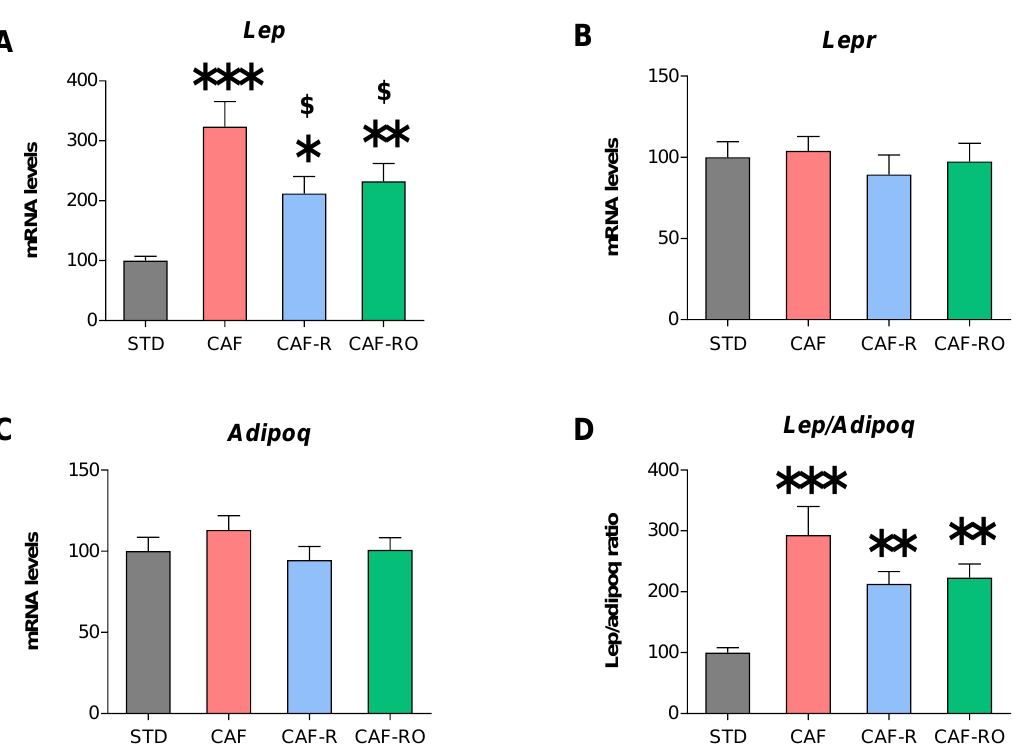
Figure 4. Effects of the dietary treatments on the mRNA levels of Lep ( A ), Lepr ( B ), Adipoq ( C ) and Lep / Adipoq ratio ( D ) in the mWAT. Data are expressed as the mean ± SEM and relativized to the STD values (%). * p < 0.05, ** p < 0.01, *** p < 0.001 vs. STD group; $ p < 0.05 vs. CAF group.